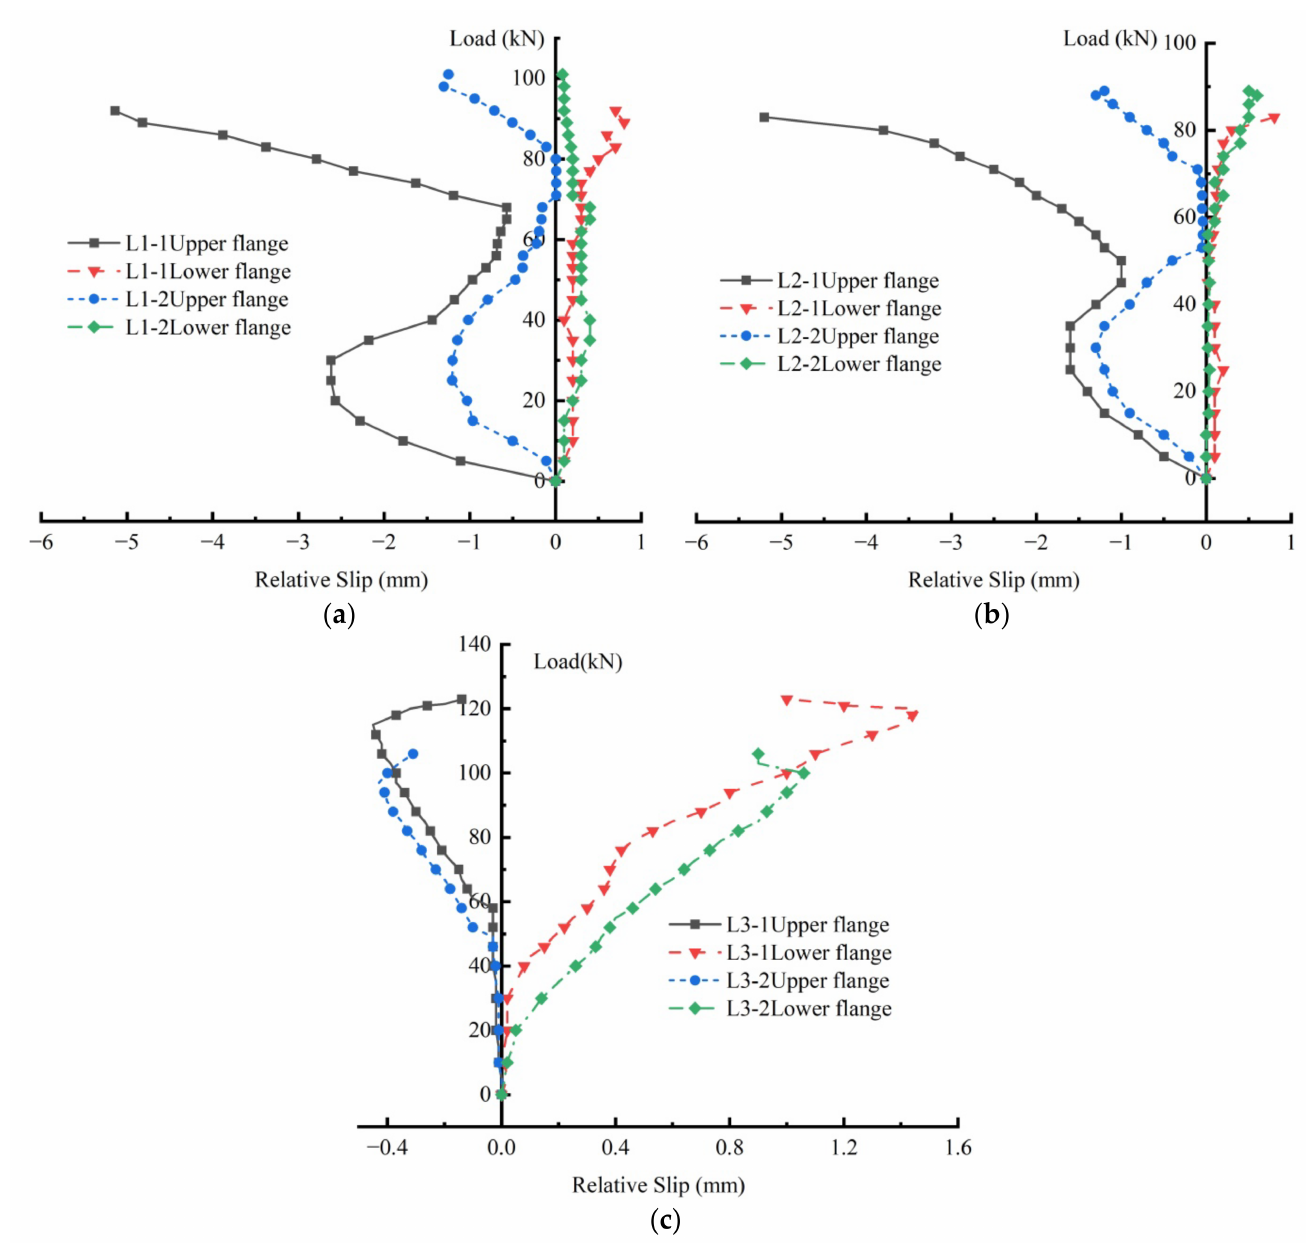
Figure 8. Load–slip response; ( a ) L1 group; ( b ) L2 group; ( c ) L3